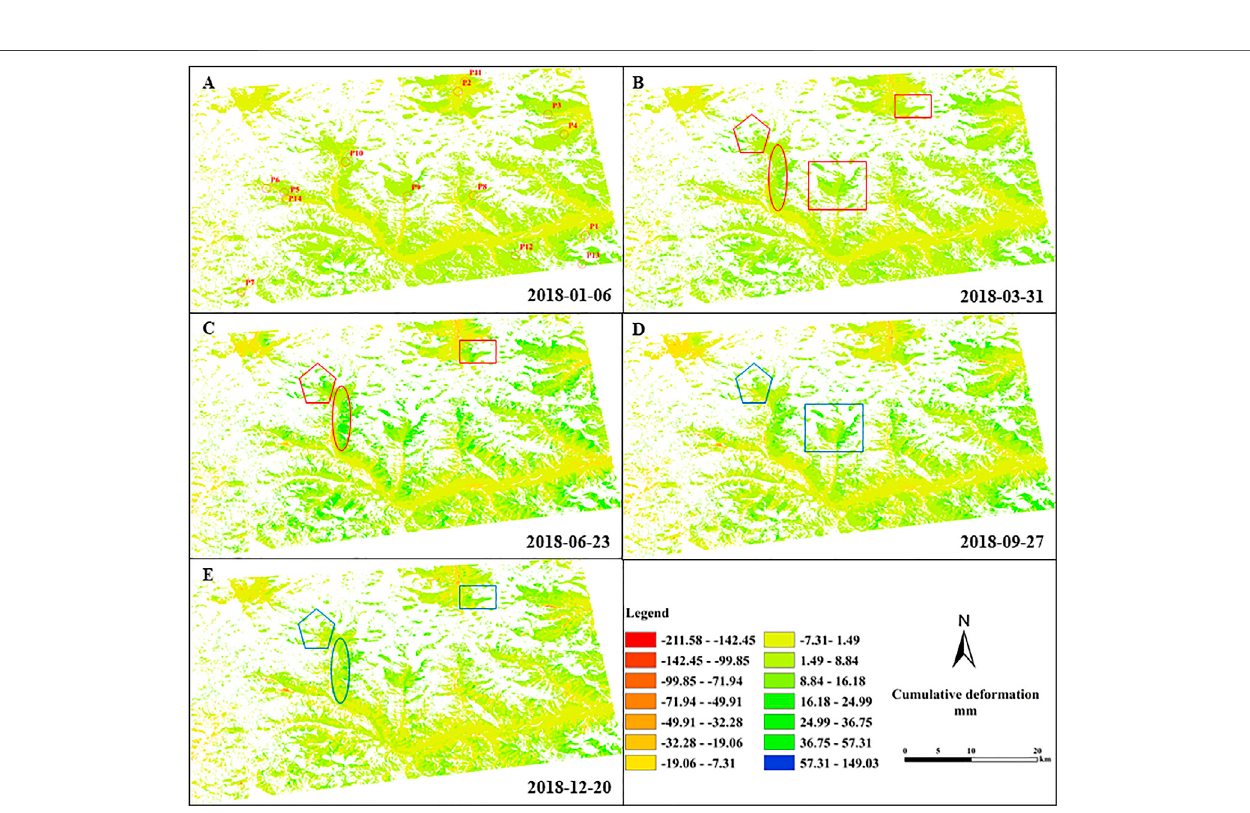
FIGURE4| Deformationvelocitystatisticsinthestudyarea.Allthevelocityvaluesareobtainedbyapplyingthe Rastertopoint toolbasedonthevelocityrasterdata.